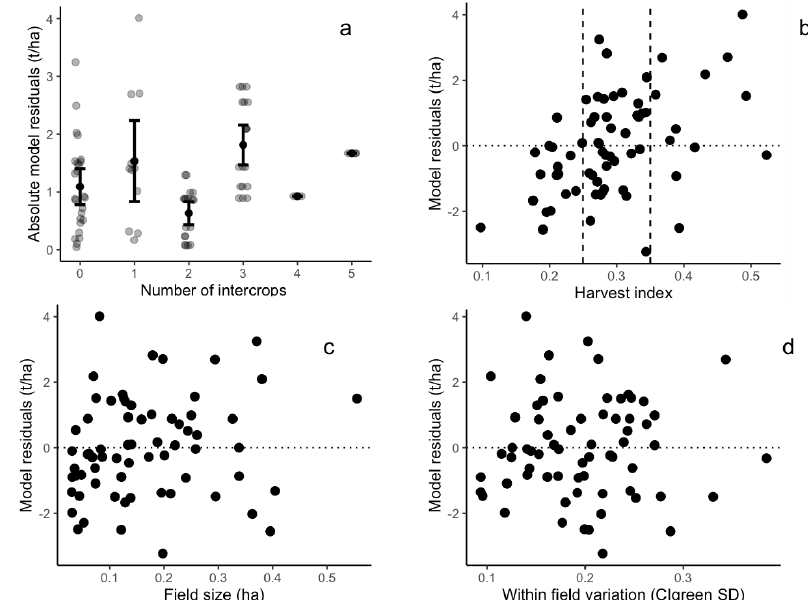
Figure 8. Scatterplots between model residuals (observed yield minus estimated yield) and field characteristics: ( a ) number of intercrops in maize fields; ( b ) maize harvest index (the vertical dashed lines show the 25th (HI = 0.25) and 75th percentiles (HI = 0.35) of the harvest index; ( c ) maize field size; and ( d ) within-field variation defined as the standard deviation of CIgreen index. The horizontal dashed lines in each panel show residuals equal to zero.